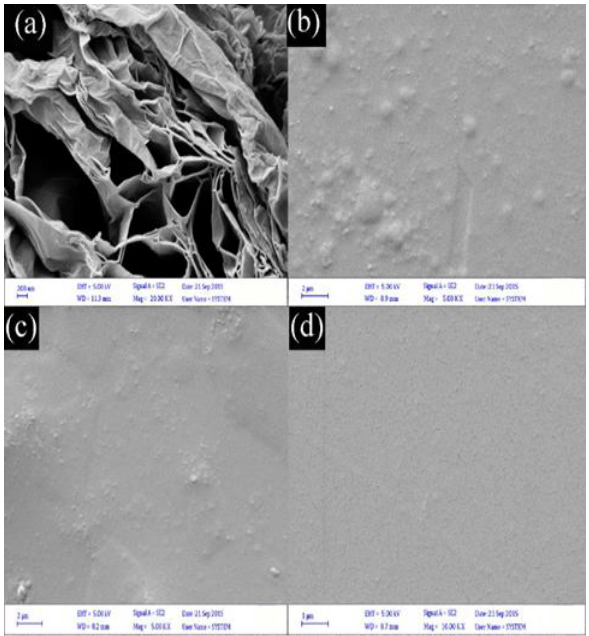
Fig. 3. SEM images of graphene nanosheets, S2, S5 and S6